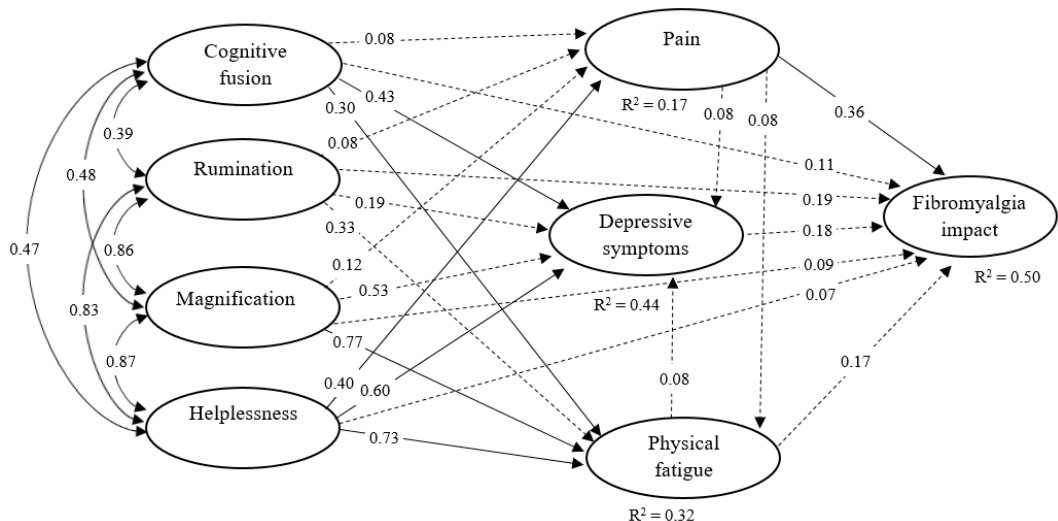
Figure 2. Standardized coefficients of the hypothesized model (M1). Dashed lines represent non-significant paths. The latent factors of the model are shown, while the observed indicators and measurement errors have been omitted for space and clarity reasons. The squared multiple regression coefficients (R 2 ) reflect the amount of factor variance associated with variance of its independent variables. Table 3. Direct association estimates of the structural models.